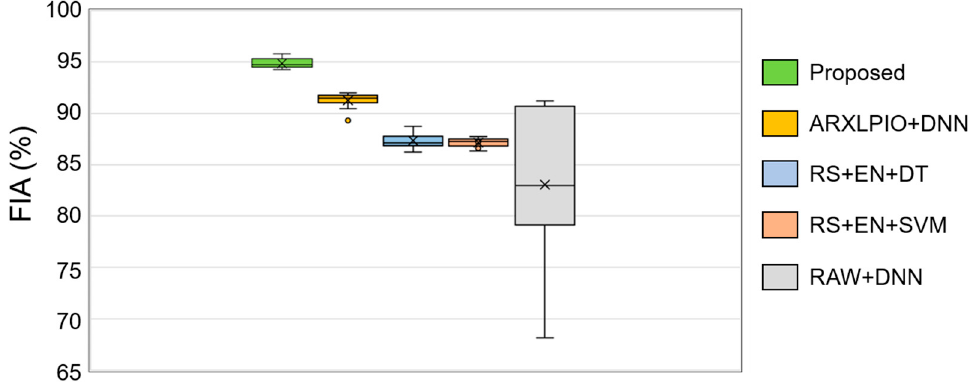
Figure 8. The boxplots demonstrating the statistics of the FIA metric over 10 experiments.